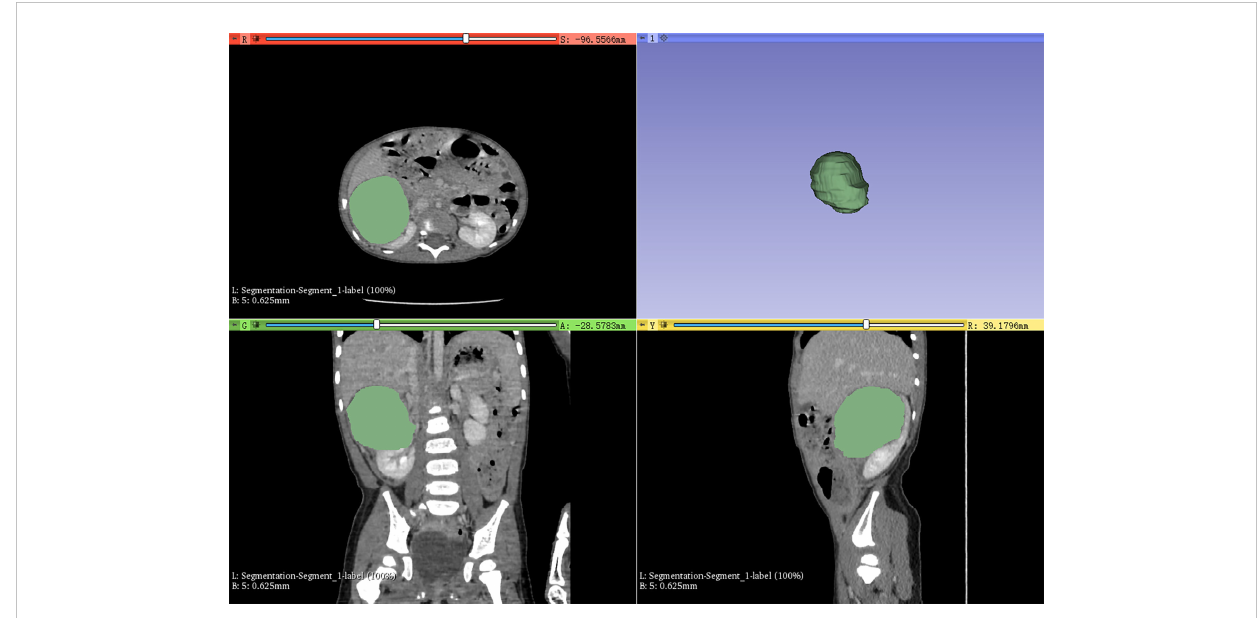
FIGURE 1 3D-Slicer was used to semi-automatically delineate the whole mass as the volume of interest for radiomics feature